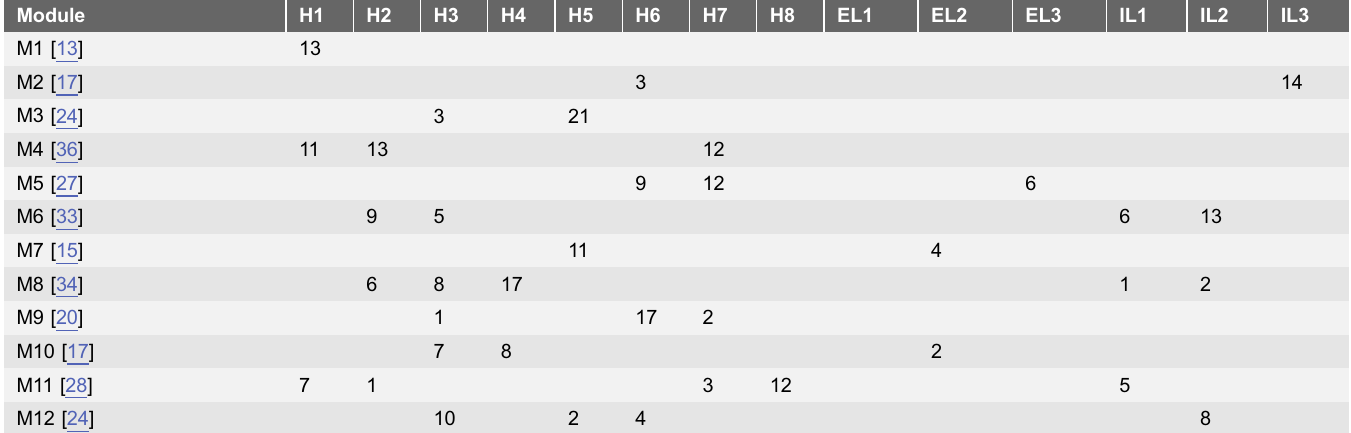
Table 6. Composition in terms of helices (H1–H8), ILs, and ELs of the different modules, i.e. , M1 to M12, as determined through the network modularization of the all-atom 0.5 m s MD simulation. Numbers between brackets correspond to the total number of residues gathered in each of the modules of the m OR structure.